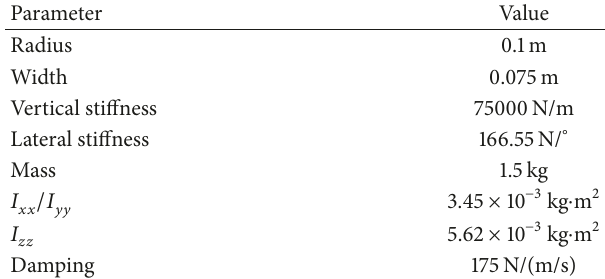
Figure 9: Tire modeling. Table 3: Tire